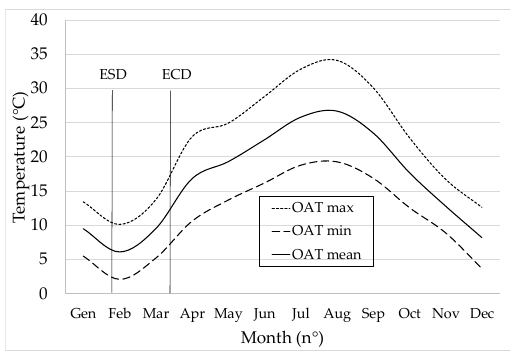
Figure 1. Monthly means of the external temperature at the experimental site and period of testing (OAT: outer external temperature; ESD: Experiment starting date; ECD: Experiment completion date).